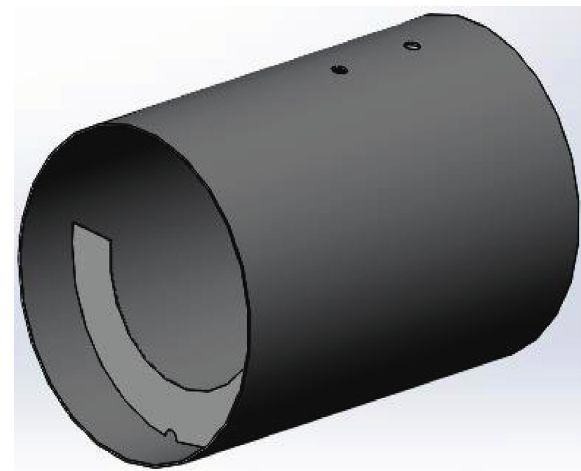
Figure 6: Drum structure diagram.